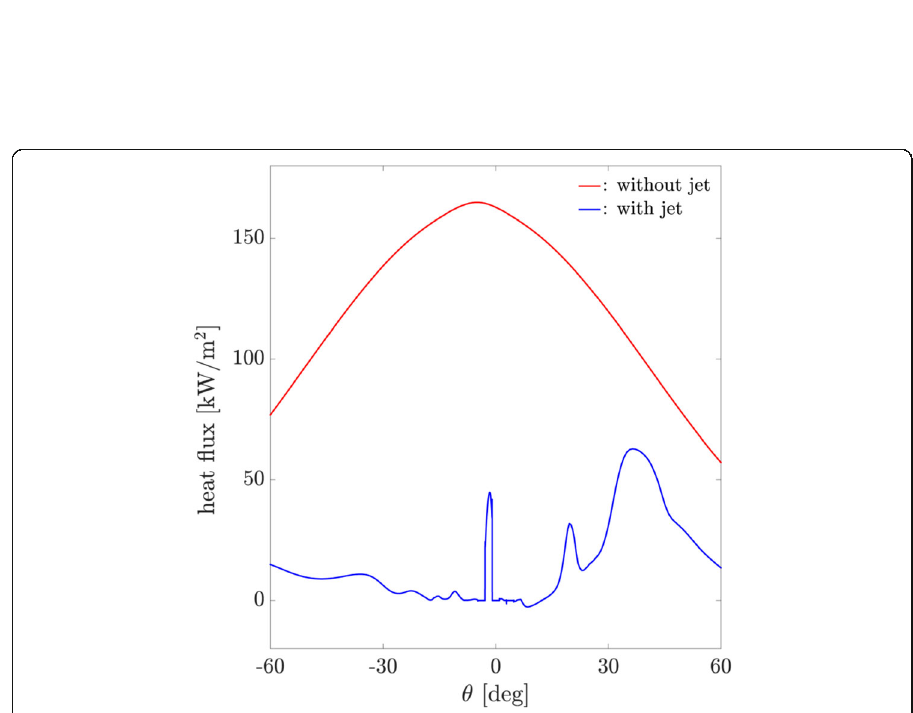
Fig. 14 The distribution of the heat flux along the cylinder corresponding to the temperature field shown in Fig. 13